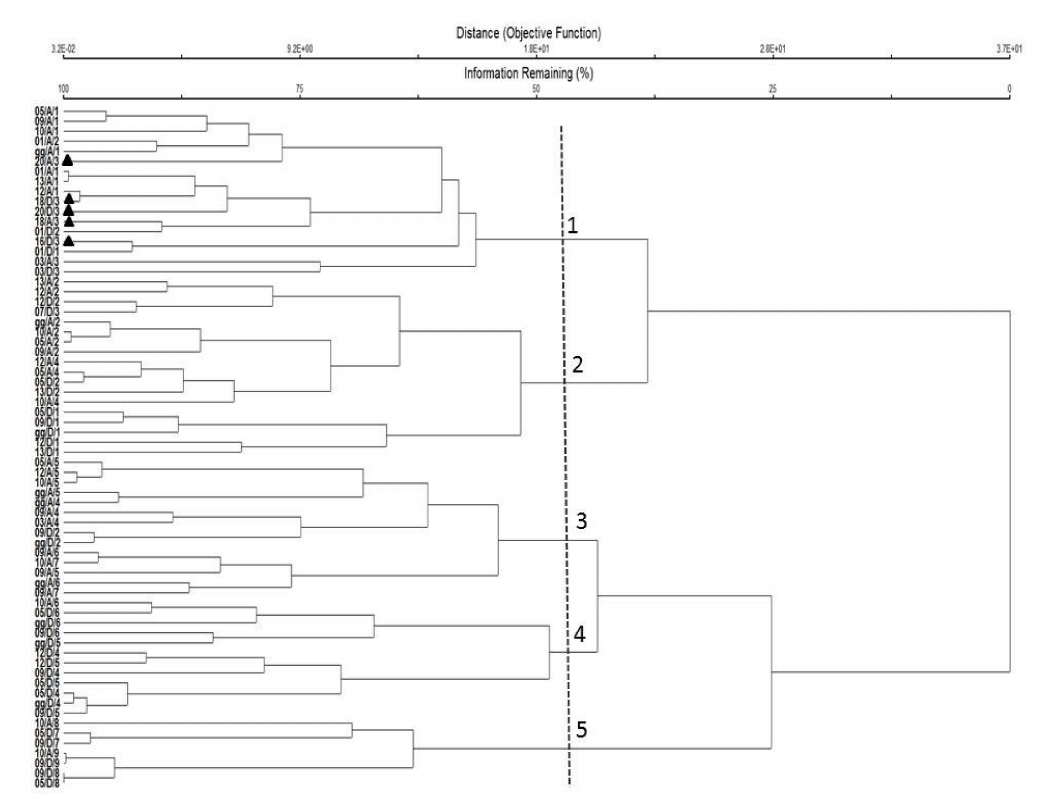
Figure 5. Cluster dendrogram of zooplankton samples taken in the Adriatic Sea in December 2015 and April 2016. Ordination is obtained by the relative Euclidean distance measure, using Ward’s linkage method on the log-transformed abundance of the copepod taxa. Samples are indicated by the sampling station, sampling period (D = December, a = April), and sampling layer (1 = 0–50 m; 2 = 50–100 m; 3 = 0–100 m; 4 = 100–200 m; 5 = 200–300 m; 6 = 300–400 m; 7 = 400–600 m; 8 = 600–800 m; 9 = 800–1200 m). Samples taken on the western Mid Adriatic stations (ESAW-16, ESAW-18, and ESAW-20) are marked with a black